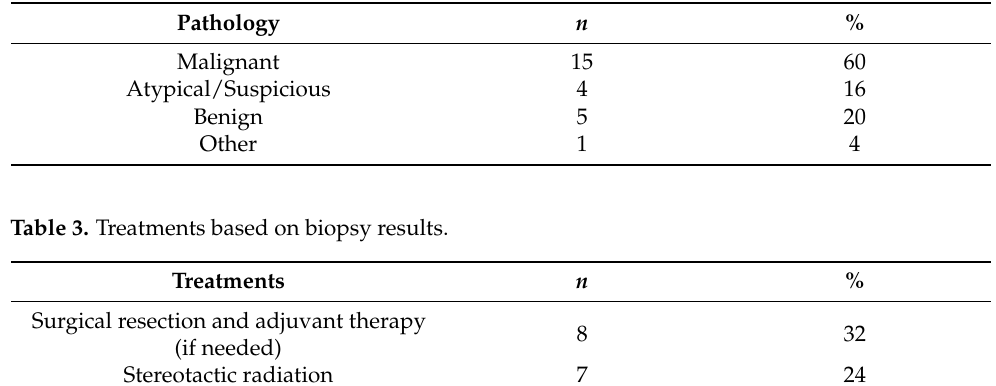
Table 2. Pathologic findings.